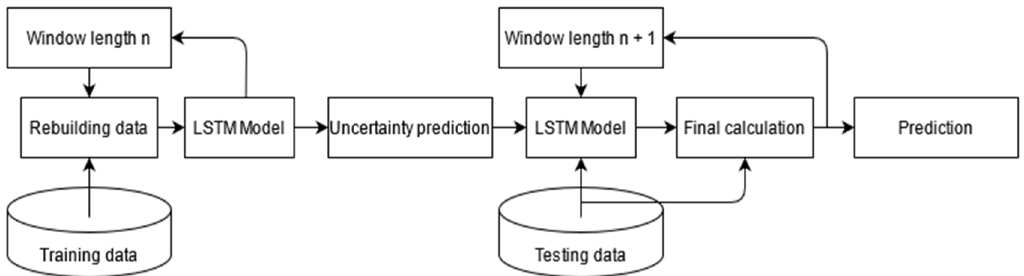
Figure 13. Proposed model for UAV anomaly